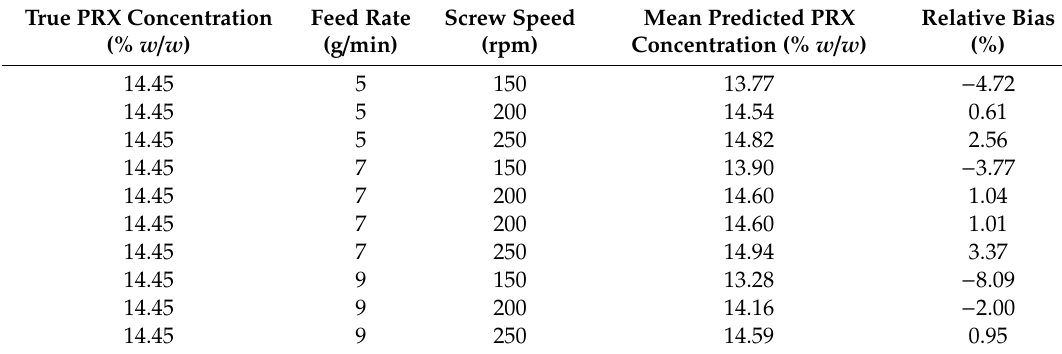
Table 6. Predicted PRX content in each DoE run.